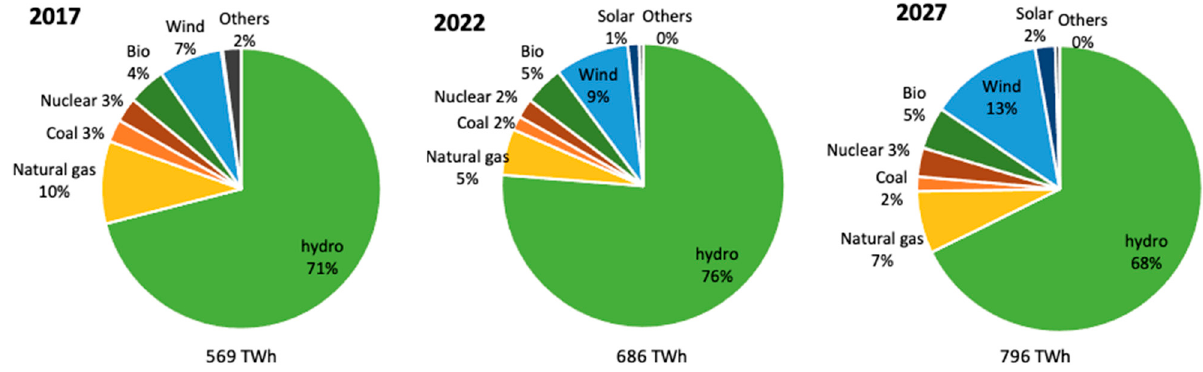
Figure 4. Decennial energy plans for the evolution of the Brazilian electrical matrix installed capacity by generation source. Data Source: [12]. Note: The data refer to the centralized internal supply of electricity excluding any distributed generation and self-production.